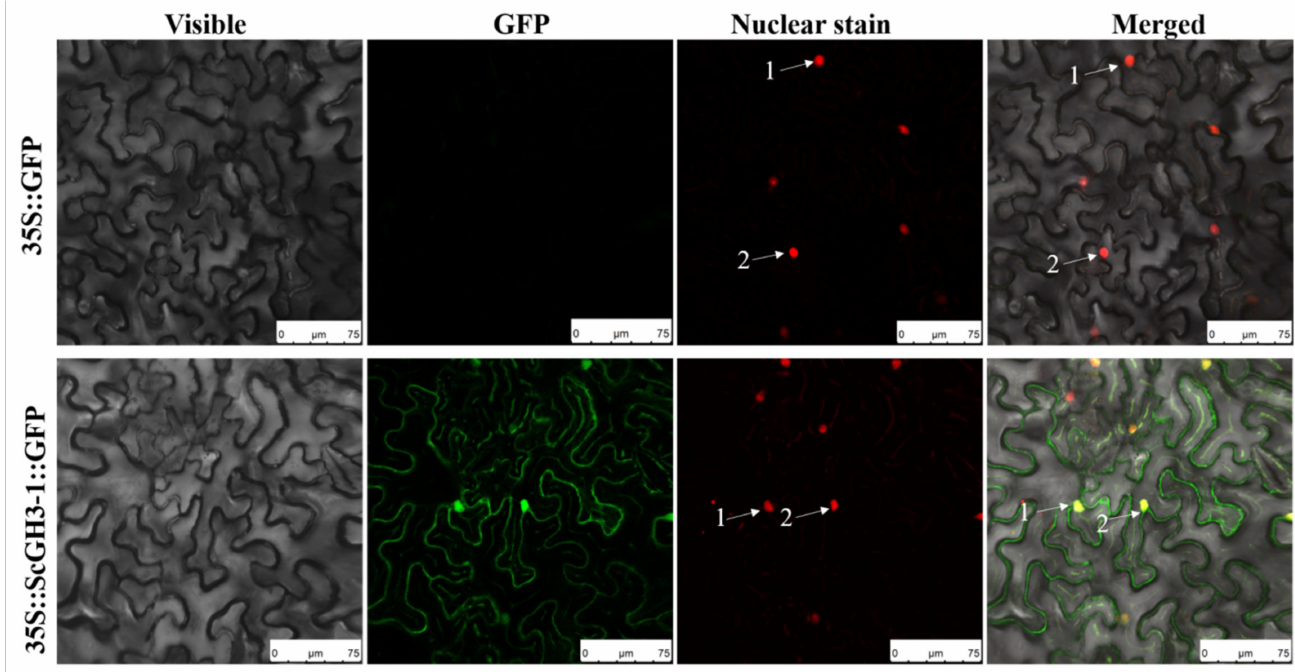
Figure 8. Subcellular localization of ScGH3-1 protein in N. benthamiana . The images were taken from three fields of view, including visible light, green fluorescence, red fluorescence, and merged green fluorescence. Here, 35S::GFP, the Agrobacterium tumefaciens strain, carried the empty vector pFAST-R05-GFP; 35S::ScGH3-1::GFP, the A. tumefaciens strain , carried the recombinant vector pFAST- R05-ScGH3-1-GFP; white arrows indicate the nucleus. H2B-mCherry is used for nuclear staining. Bar = 75 µ